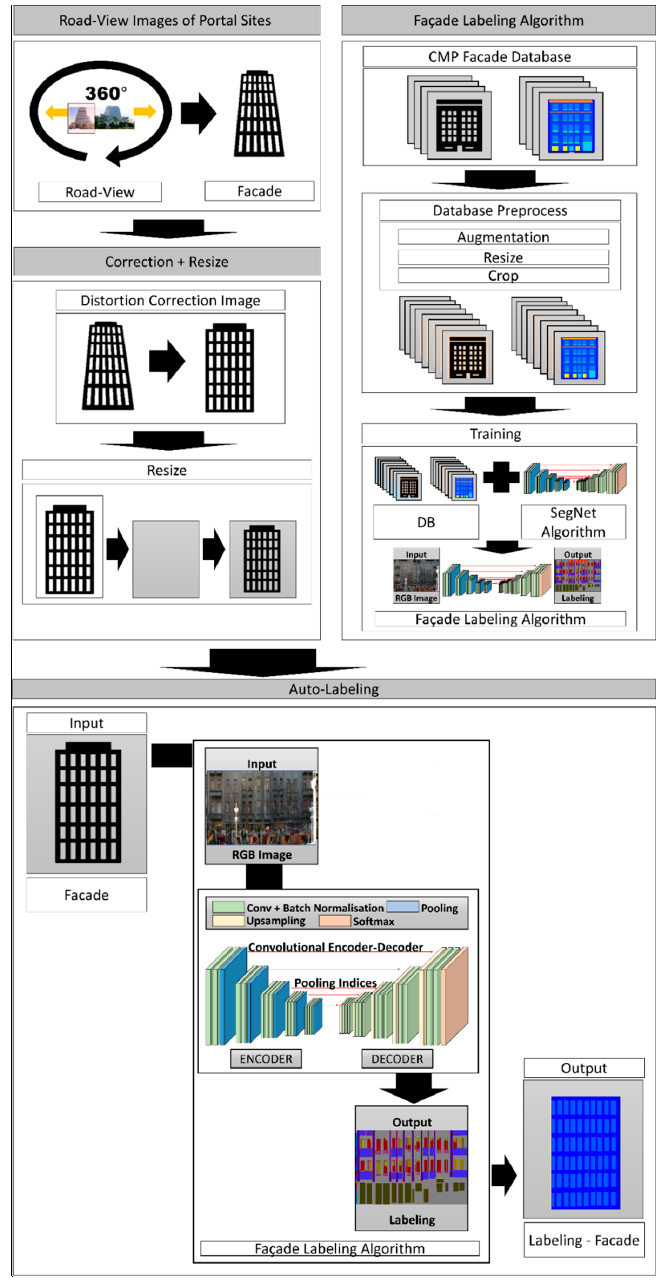
Figure 5. Framework of the proposed construction